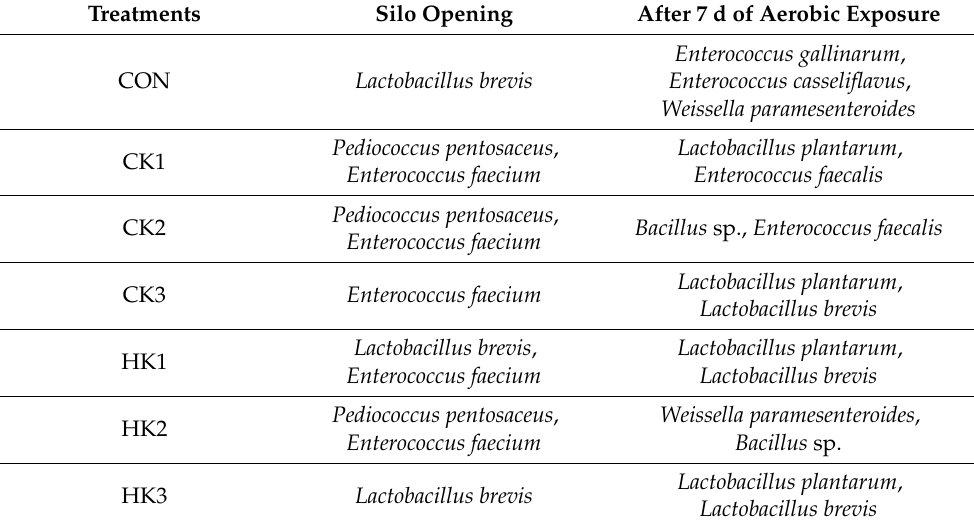
Table 3. 16SrRNA sequences isolated from ensiling alfalfa treated with different kefir sources.